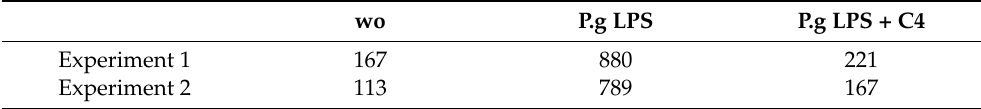
Figure 1. Butyrate suppressed P. gingivalis LPS-induced IL6 and CXCL2 expression in RAW 264.7 cells. RAW 264.7 cells were exposed for 24 h to 10 mM of acetate (C2), propionate (C3), and butyrate (C4) in the presence of 1 µ g/mL P. gingivalis LPS. Each format shape represents data from individual experiments with the median. Statistical analysis was based on the Friedman test and corrected p values are indicated. Table 1. Butyrate suppressed P. gingivalis LPS-induced IL6 production of RAW 264.7 cells. RAW 264.7 cells were exposed for 24 h to 10 mM of butyrate (C4) in the presence of 1 µ g/mL P. gingivalis LPS. Data represent the concentration of IL6 in pg/mL in the supernatant from two independent